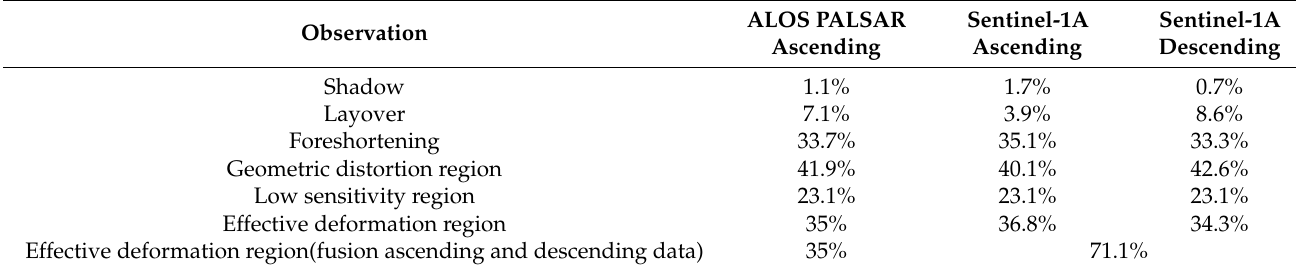
Table 2. SAR data observation information